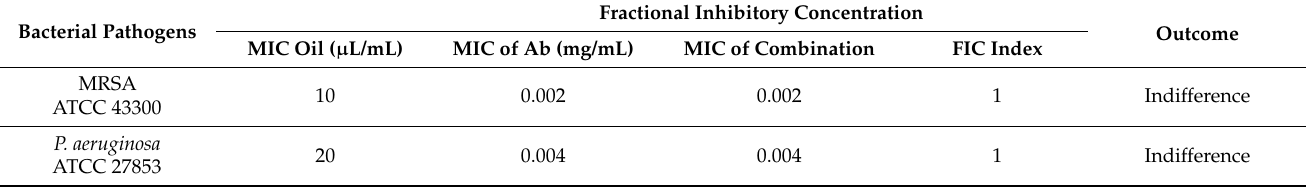
Table 2. The fractional inhibitory concentration of frankincense oil with different concentrations of antibiotics.